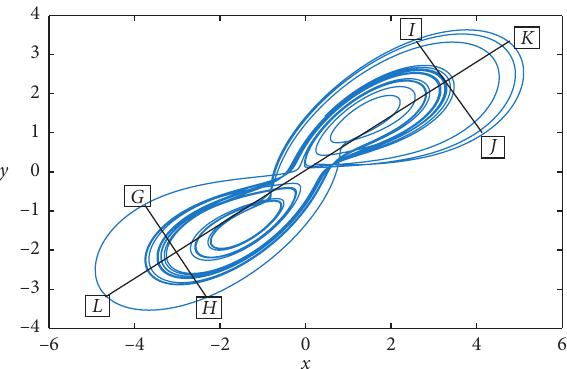
Figure 3: Phase spaces with polygon with the order α � 0 . 9. Figure 4: Phase spaces with polygon with the order α � 0 . 95.